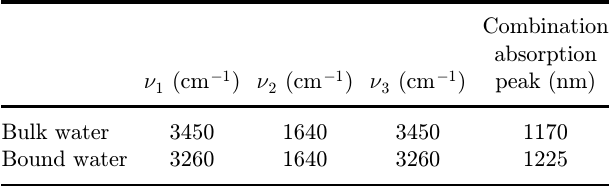
Table 1. Fundamental vibrations and combination absorp- tion peaks of bulk and bound